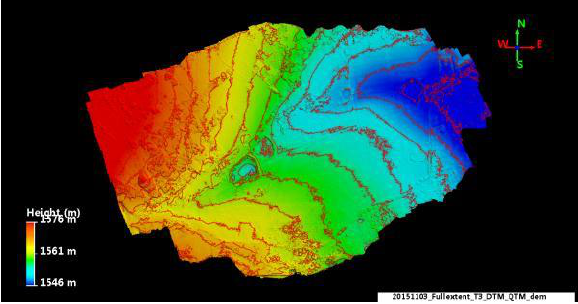
Figure 5. A 0.29 m ground pixel resolution DTM of the study area with QTM height colouration and 2.5 m contours A slope/profile analysis was calculated (Fig.6) using the 0.29 m